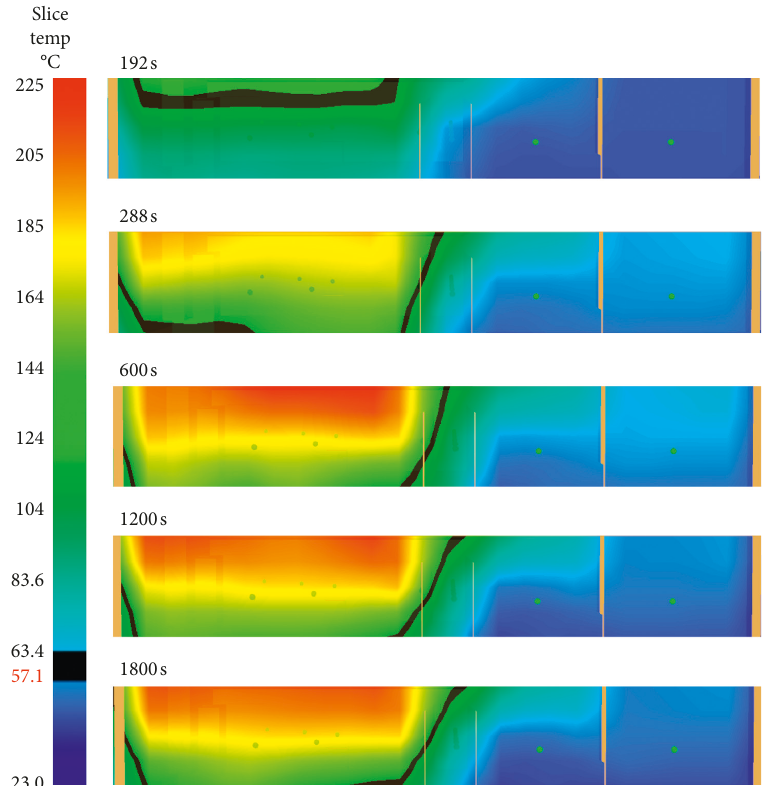
Figure 11: Temperature slice of fire scenario